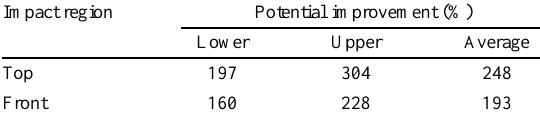
Potential for improving helmet designs based on HIC Impact